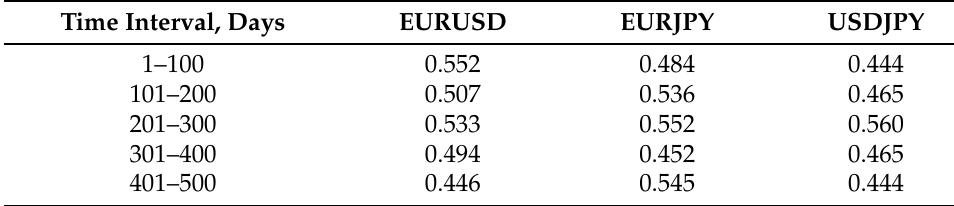
Table 1. Positive outcome frequency at dL =